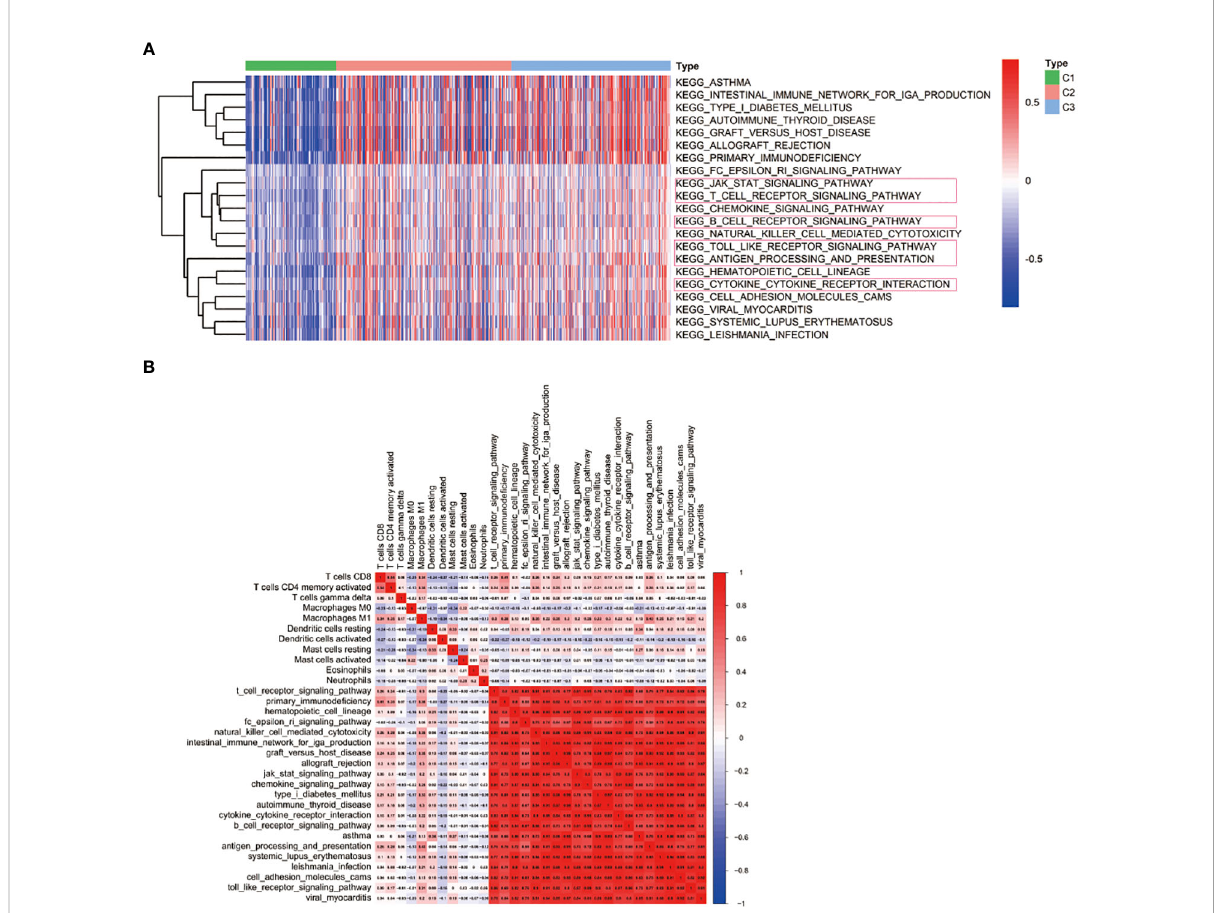
FIGURE 6 Immune-related pathways associated with immune-based subtypes. (A) KEGG pathway enrichment analysis; (B) Heat map displaying the association of immune cells and signaling